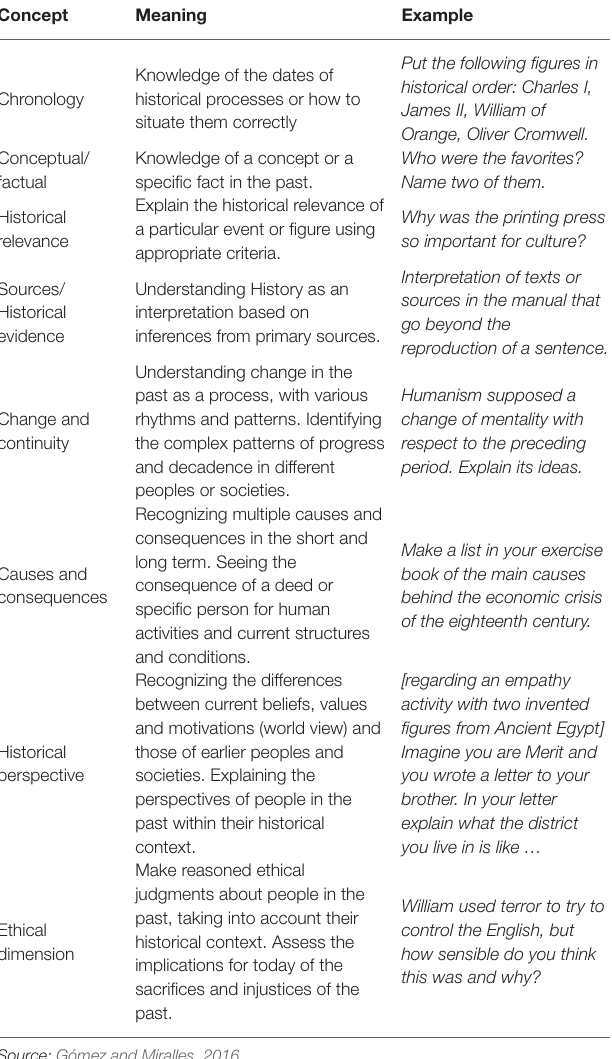
TABLE 3 | Meaning and example of the categorization of first and second-order concepts in the textbook activities. Concept Meaning Example